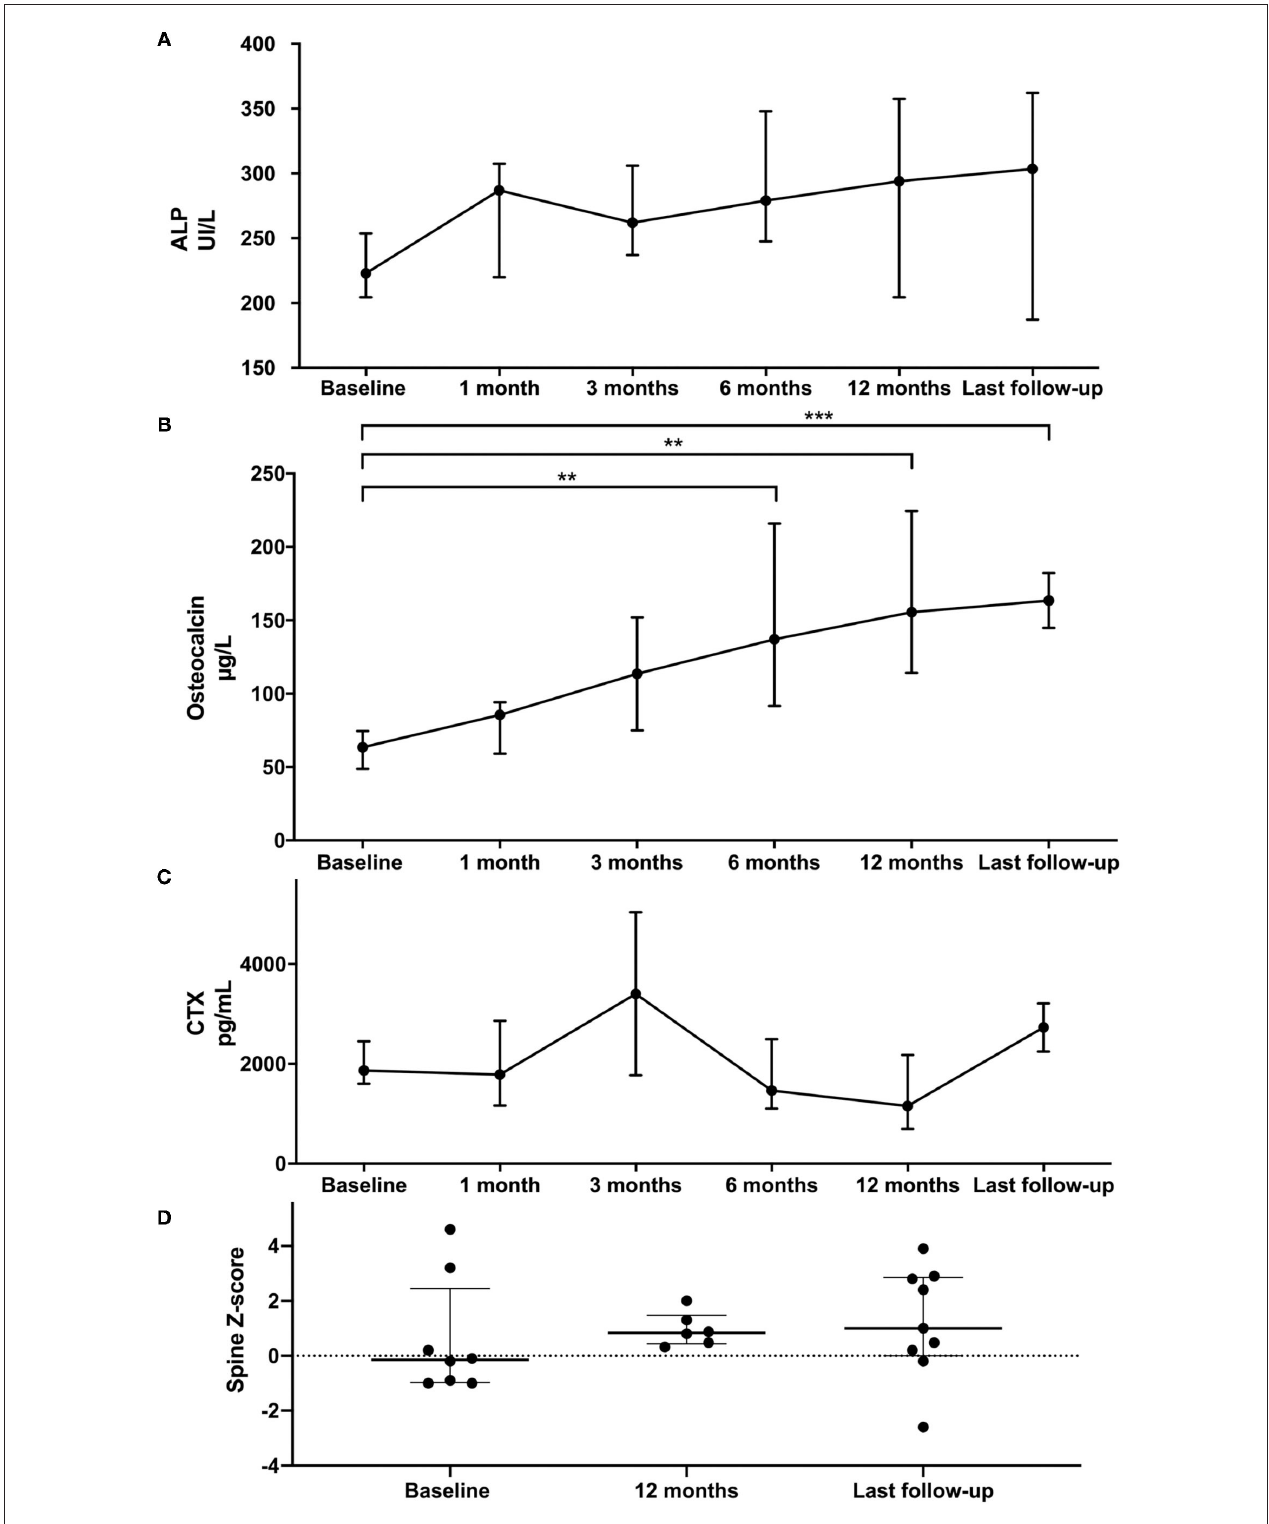
FIGURE 3 | Comparison of ALP (A) , osteocalcin (B) , CTX (C) , and DXA spine (D) data at teriparatide initiation and during follow-up. Each dot on the graph represents median with interquartile range of biomarker levels at the different time-points. Statistical analyses were performed with Kruskall Wallis test: ** p < 0.01 and *** p <